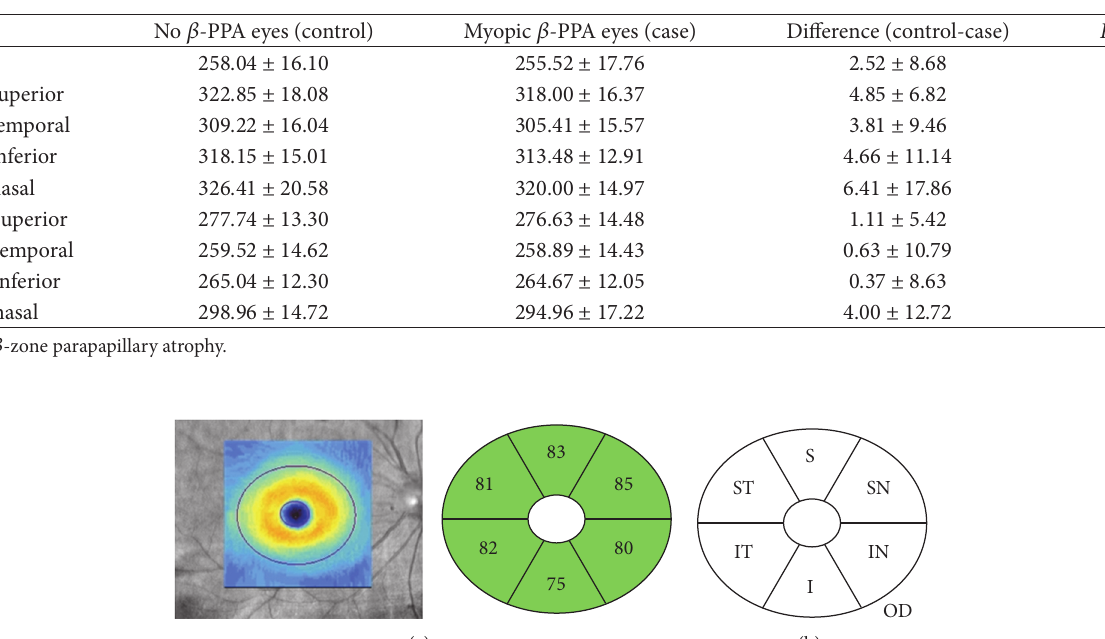
Table 3: Average of macular thickness ( 𝜇 m).